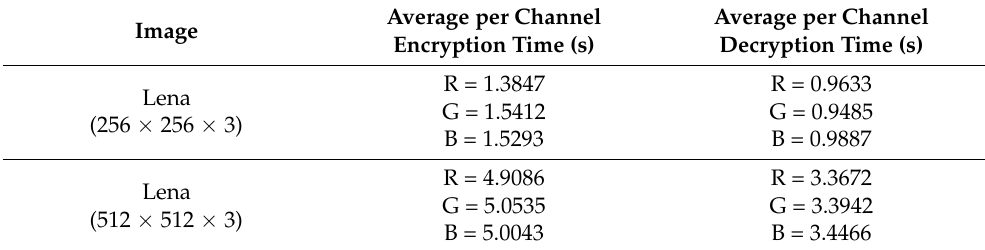
Table 13. Speed analysis by measuring the encryption and decryption time in